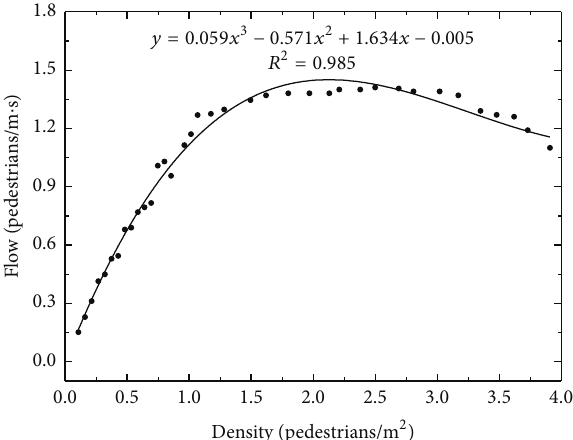
Figure 2: Flow-density fundamental diagram of the observed